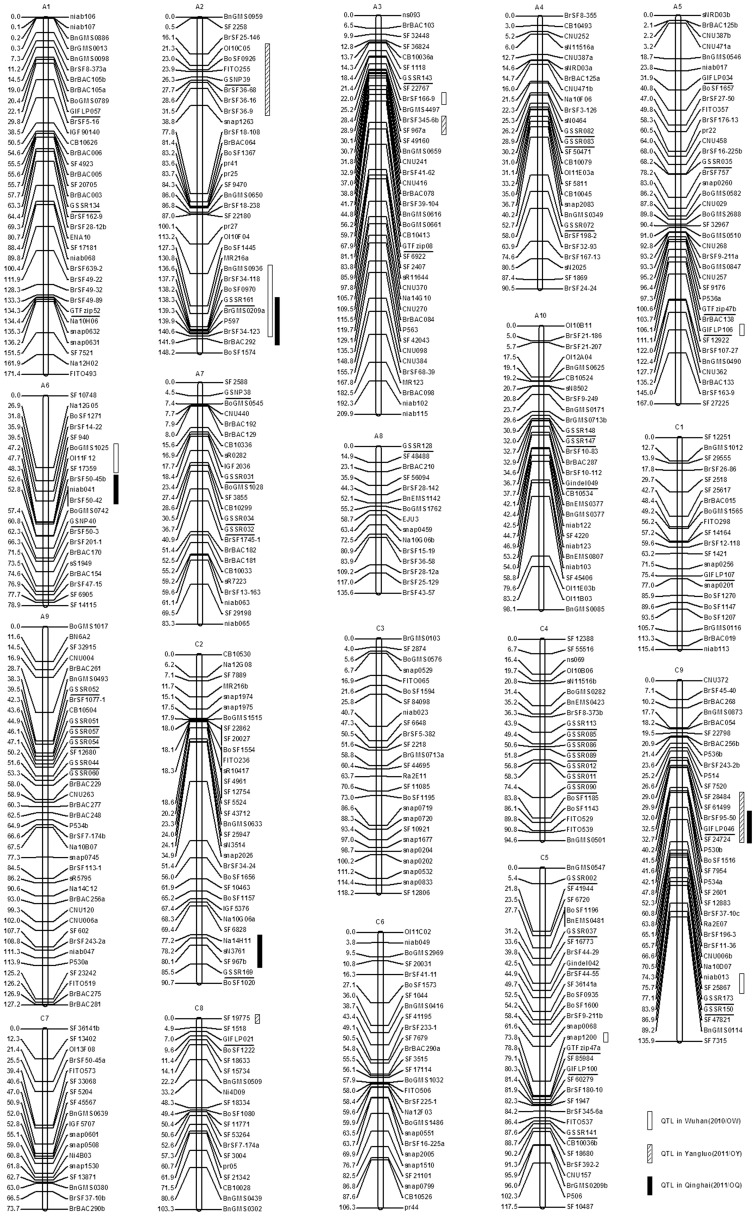
Genetic linkage map and positions of QTL in DH genetic linkage map.DH population was derived from a cross between zy036 and 51070. Linkage groups successfully assigned to A genome (A1–A10) and C genome (C1–C9). Newly developed primers related to oil-content genes are underlined and confidence intervals of QTL for seed oil content are tagged on the right side of linkage groups. White rectangles indicate QTL in Wuhan (2010/OW), striped rectangles indicate QTL in Yangluo (2011/OY), and black rectangles indicate QTL in Qinghai (2011/OQ).